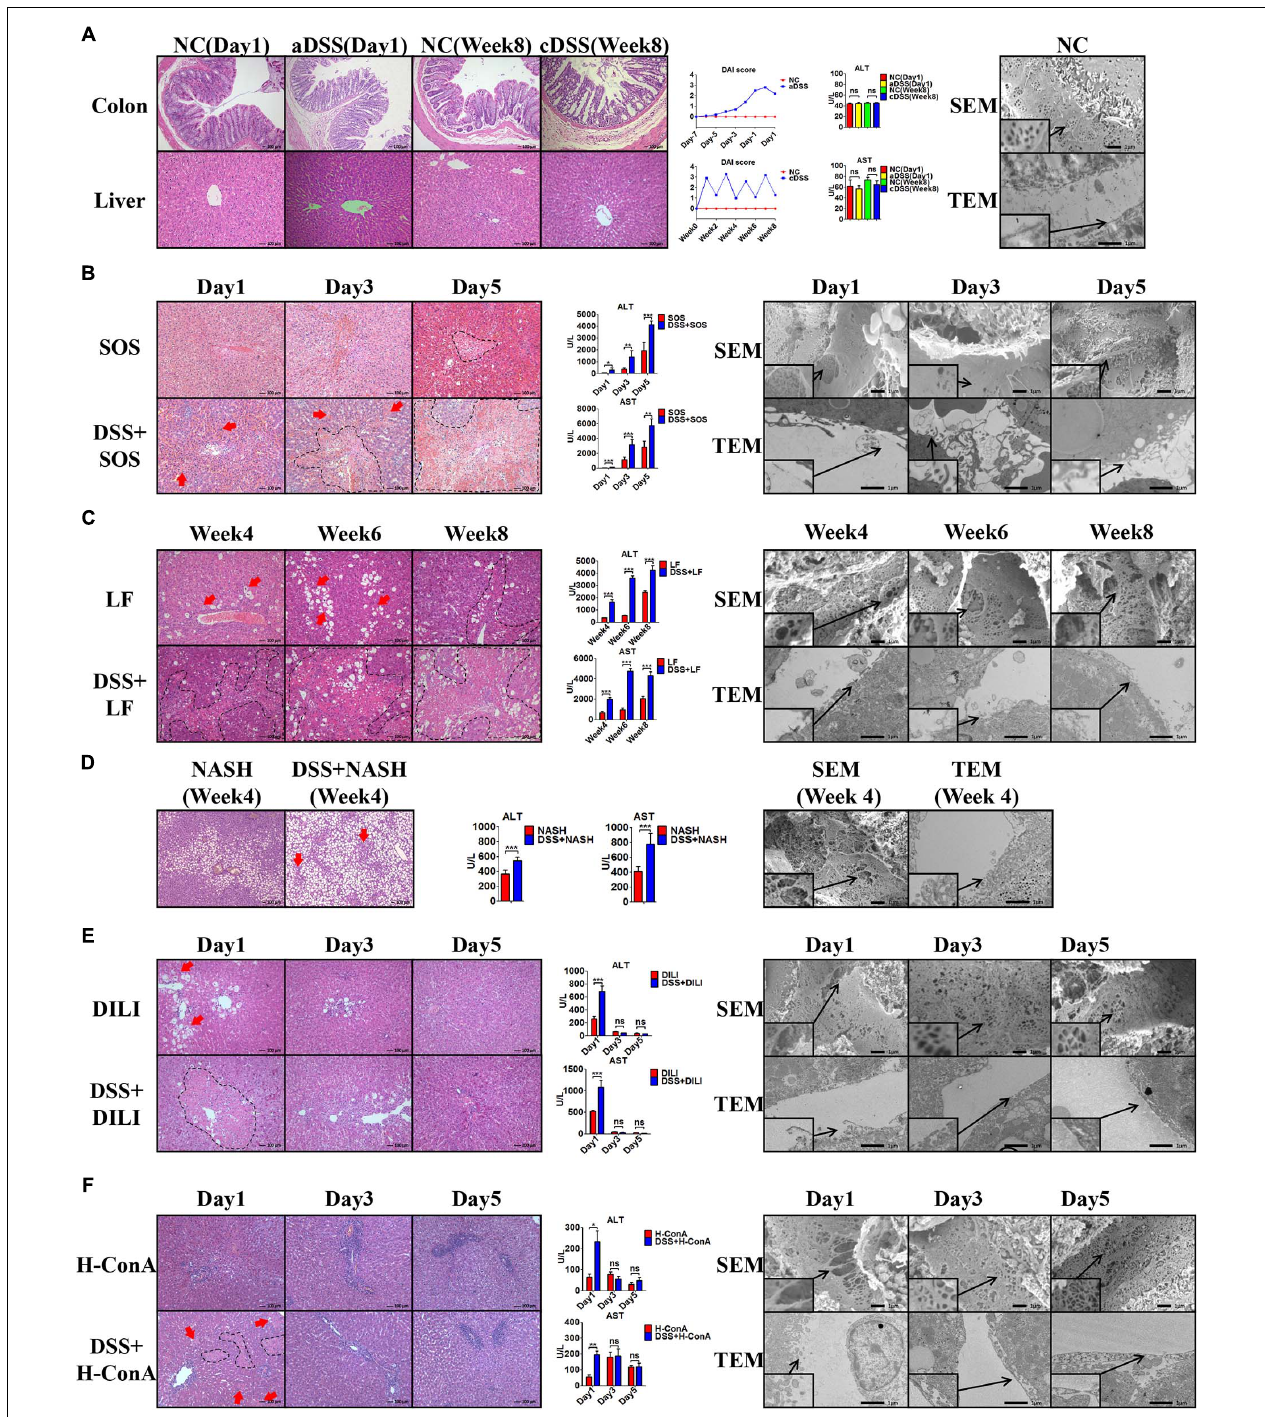
FIGURE 1 | Colitis aggravates liver injury when LSECs are damaged. (A) H&E staining was used to investigate the pathological findings of colon and liver in normal control (NC), acute dextran sulfate sodium (DSS) colitis (aDSS) group, and chronic DSS colitis (cDSS) group. Disease Activity Index (DAI) score was used to evaluate the severity of colitis during the course of disease. Alanine aminotransferase (ALT) and aspartate aminotransferase (AST) were tested to evaluate liver injury. Scanning electron microscopy (SEM) and transmission electron microscopy (TEM) showed the ultrastructural features of normal liver sinusoidal endothelial cells (LSECs). The effect of DSS colitis on liver injury and the damage of LSECs were also evaluated in (B) the sinusoidal obstruction syndrome (SOS) model; (C) the liver fibrosis (LF) model; (D) the non-alcoholic steatohepatitis (NASH) model; (E) the drug-induced liver injury (DILI) model; and (F) the high-dose ConA hepatitis (H-ConA) model. ns, non-significant; * p < 0.05; ** p < 0.01; *** p < 0.001 by t -test; n = 6 at each time point per group; figures are representative of three experiments.